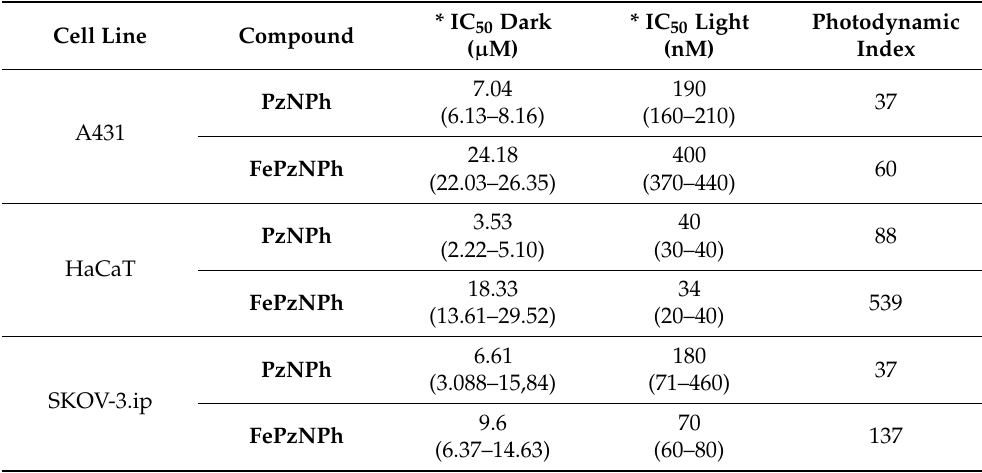
Table 2. Dark toxicity and photodynamic activity of PzNPh and FePzNPh against A431, HaCaT, and SKOV-3.ip